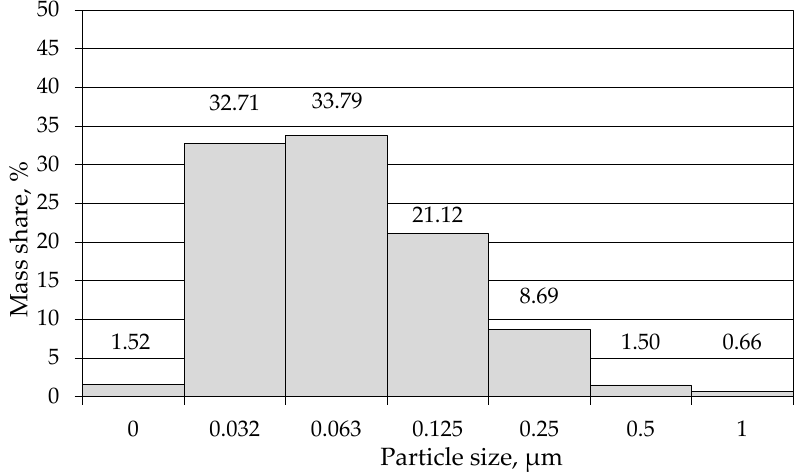
Figure 1. Sieve analysis of dust from narrow-surface treatment lines.